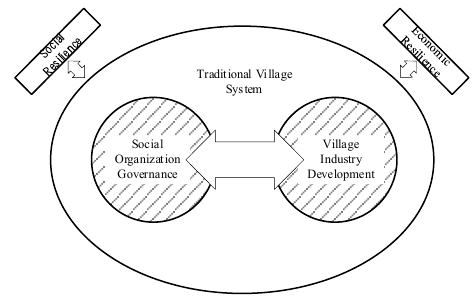
Figure 11. S&C mode diagram. Table 14. Action mechanism of each path mode.